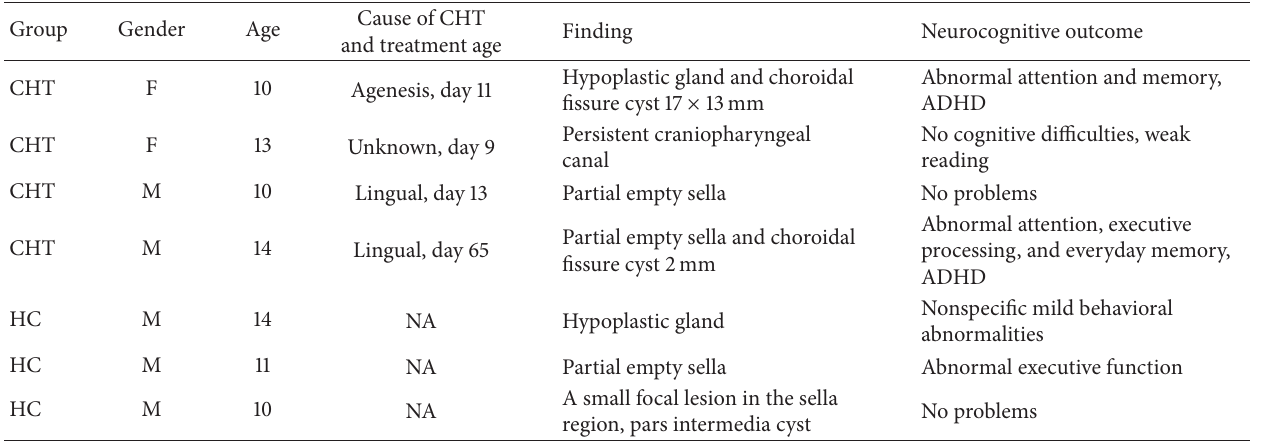
Table 2: Characteristics of participants with incidental abnormal findings at the sella